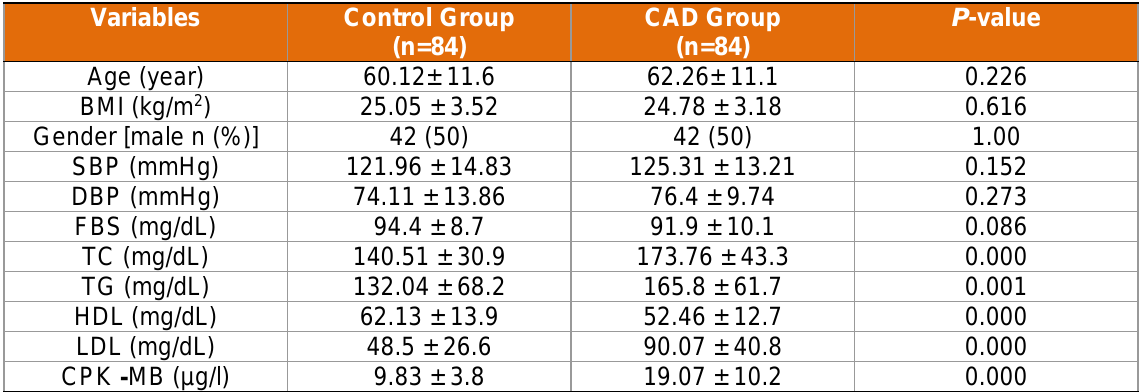
BMI, body mass index; CPK- MB, Creatine phosphokinase-MB; DBP, diastolic blood pressure; FBS, Fasting blood sugar; HDL, high density lipoprotein; LDL, Low density lipoprotein; SBP, systolic blood pressure; TC, total cholesterol; TG,